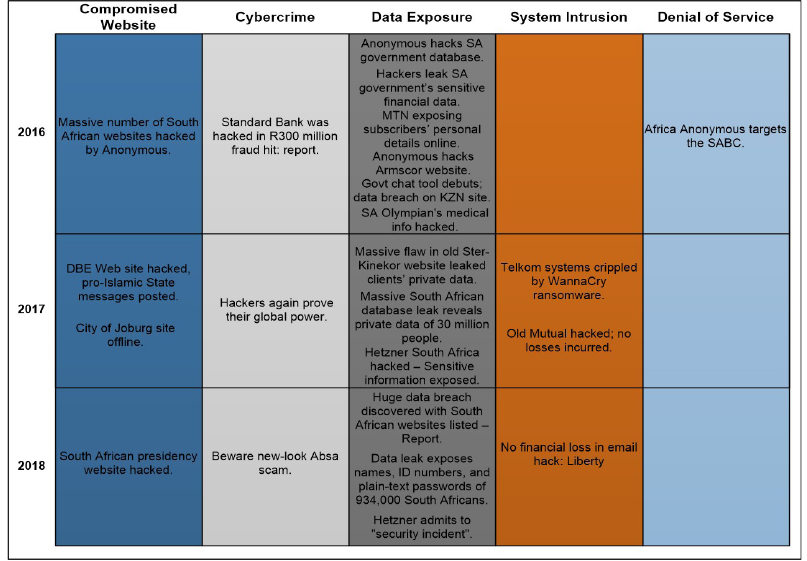
Figure 3: Classification of cyber incidents by type, 2016 – 2018 (23 incidents)